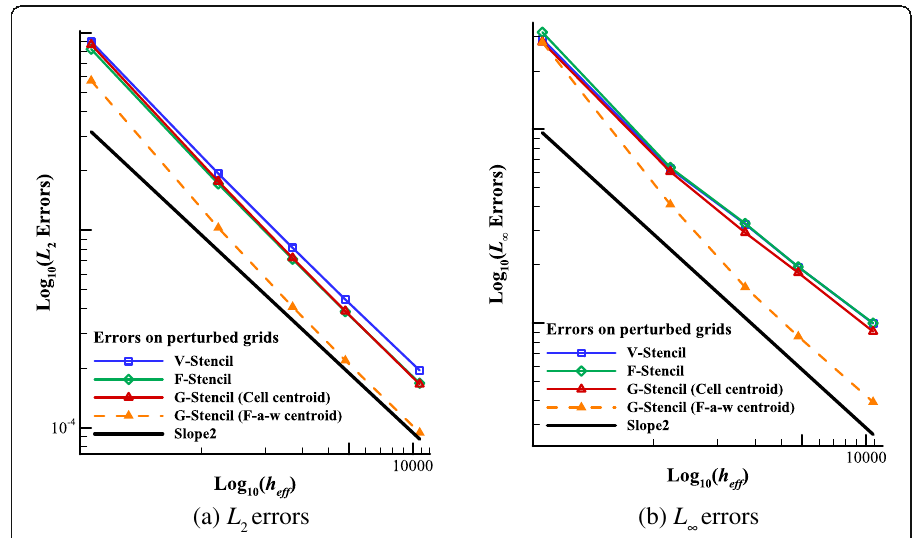
Fig. 15 ( a ) L 2 and ( b ) L ∞ errors. Errors of different stencils on randomly perturbed grids with AR = 10